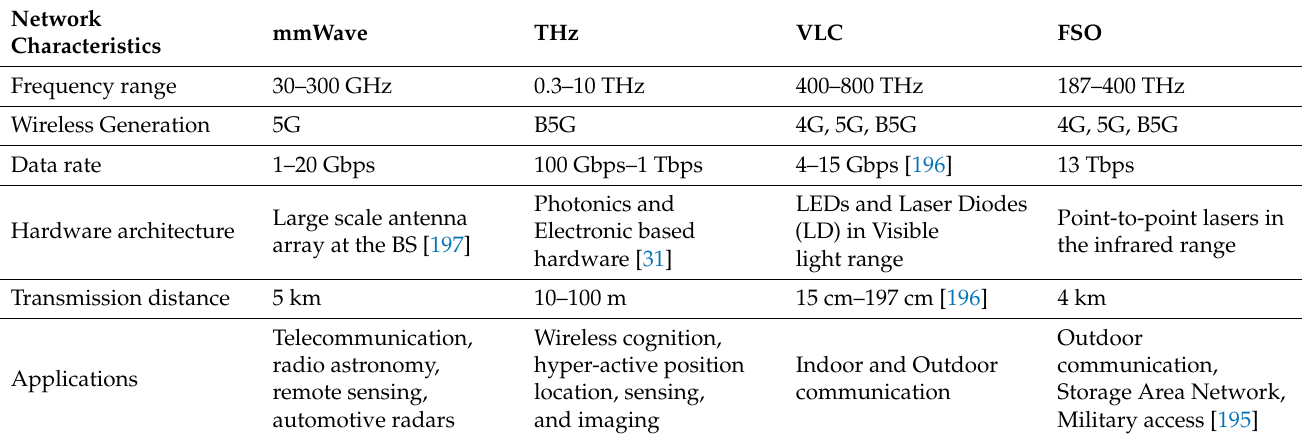
Table 12. Comparison of mmWave, THz, VLC and